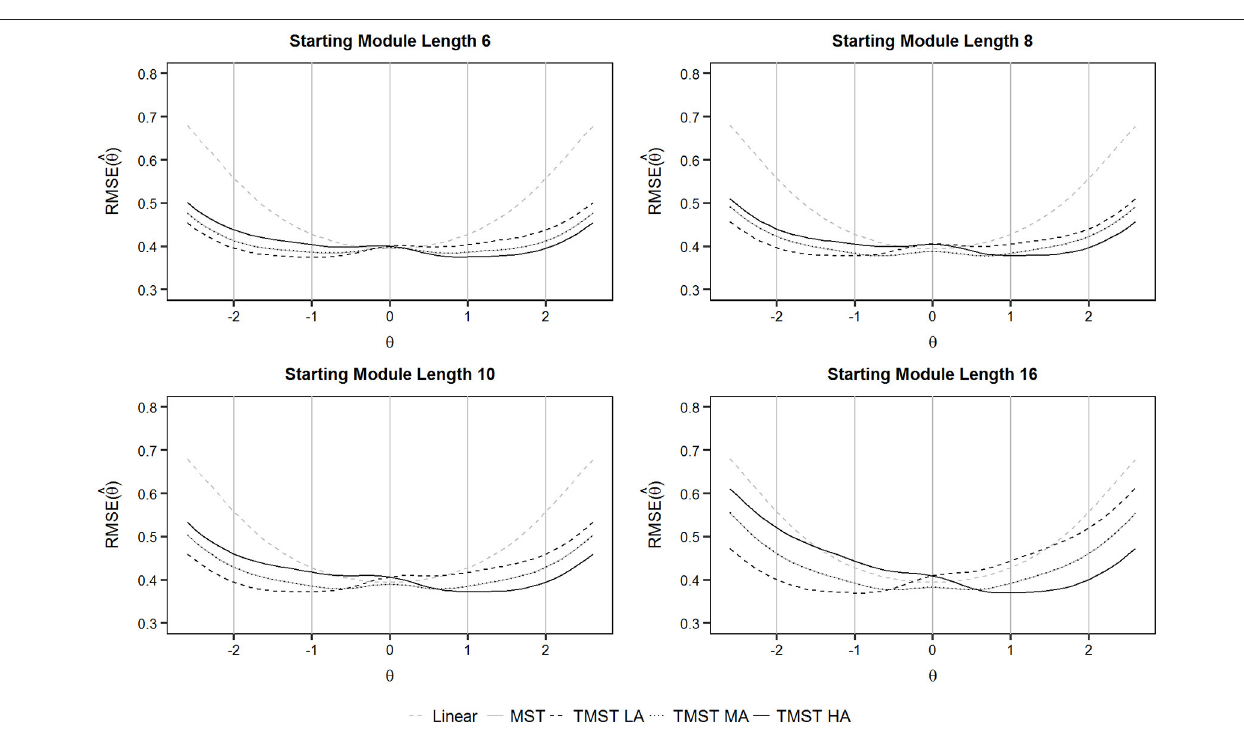
FIGURE 6 | RMSE( ˆ θ ) in relation to ability for the MST and TMST designs with different lengths of starting modules per ability group. LA, low-ability group; MA, medium-ability group; HA, high-ability